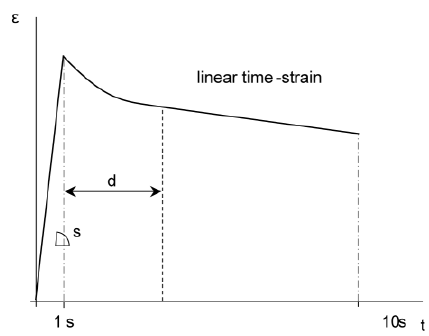
Figure 7. Physical meaning of s and d parameters for a generic creep-recovery cycle.